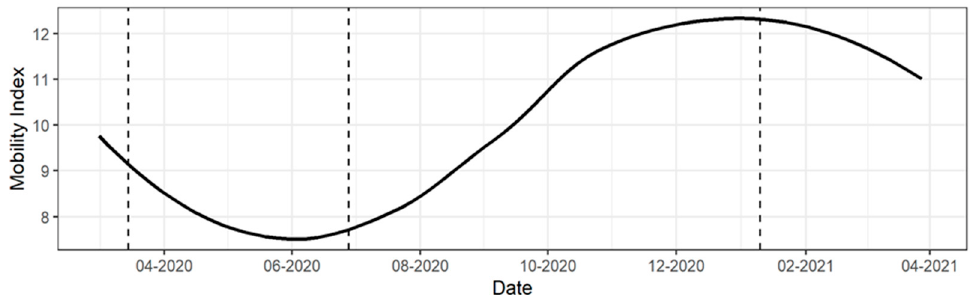
Figure 2. Sample of a mobility process applied to the Valparaíso Commune in Central Chile. 3 defined periods, from left to right: 1. Pre-Quarantine Mobility, 2. Quarantine Mobility, 3. Post-Quarantine Mobility.